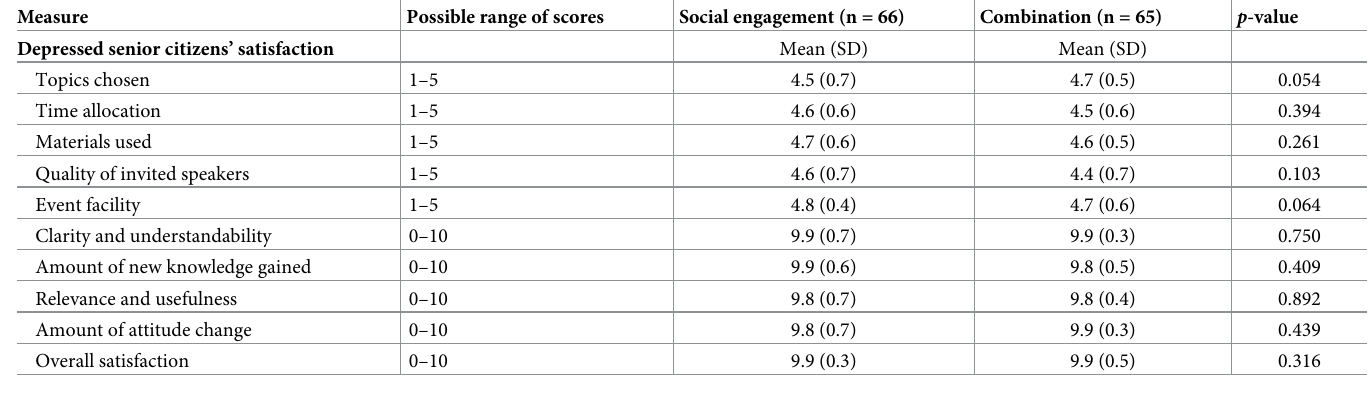
Table 4. Evaluation of social engagement